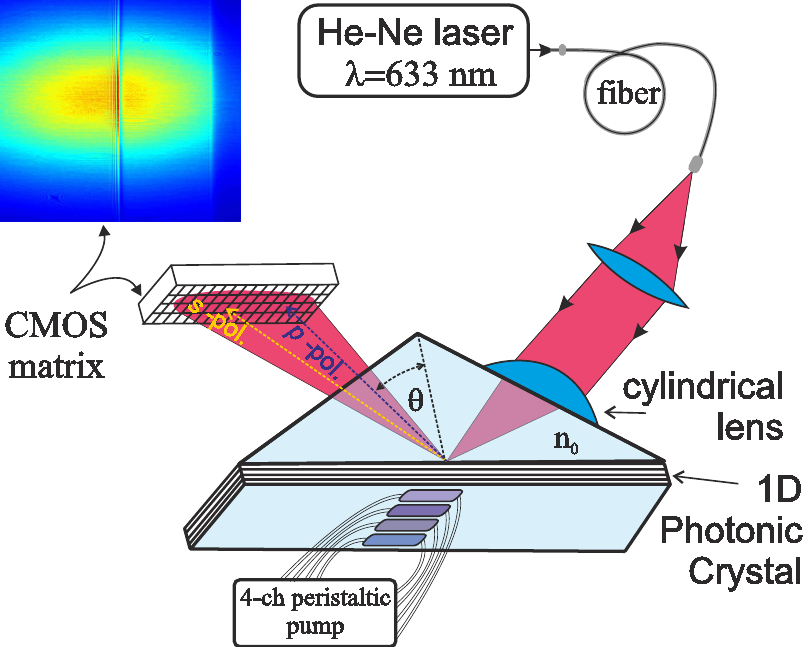
Figure 1. A sketch of the EVA biosensor based on angle interrogation of a photonic crystal surface mode (PC SM). A circular-polarized laser beam from a stabilized He–Ne laser is sent to the sensor surface through a polarization-maintaining fiber cable. The beam is focused by a cylindrical lens in such a way that the excitation angle of one s-polarized PC surface mode (existing in this 1D PC) and TIR angle (in p-polarization) are contained in the convergence angle of the beam. The reflected angular profile (see the color inset) is recorded by the CMOS matrix. The one-dimensional spatial selectivity of this setup allows simultaneous recording of biochemical reactions in four fluid